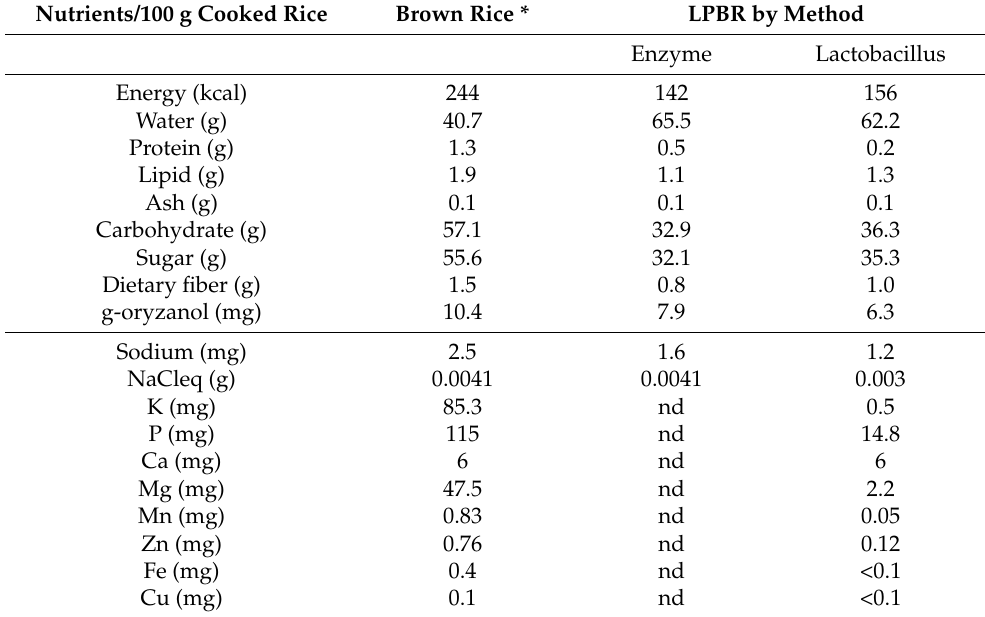
Table 2. Nutrients in the new